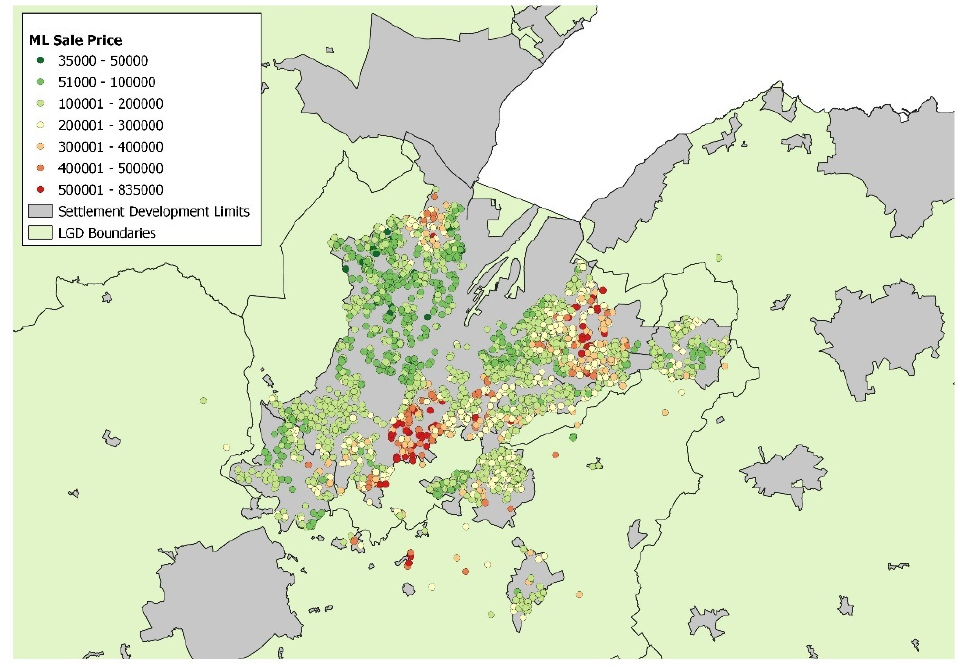
Figure 1. The geographic distributions of house prices across the Belfast housing market area.